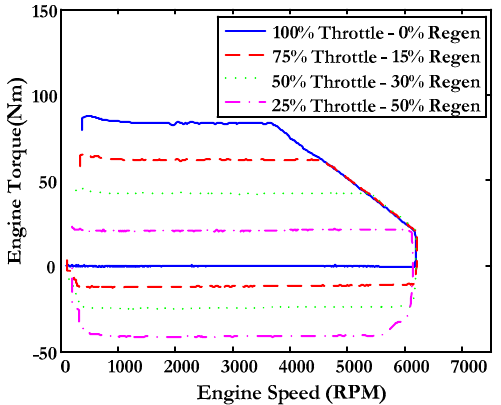
Figure 1. Torque curves of the electric motor.